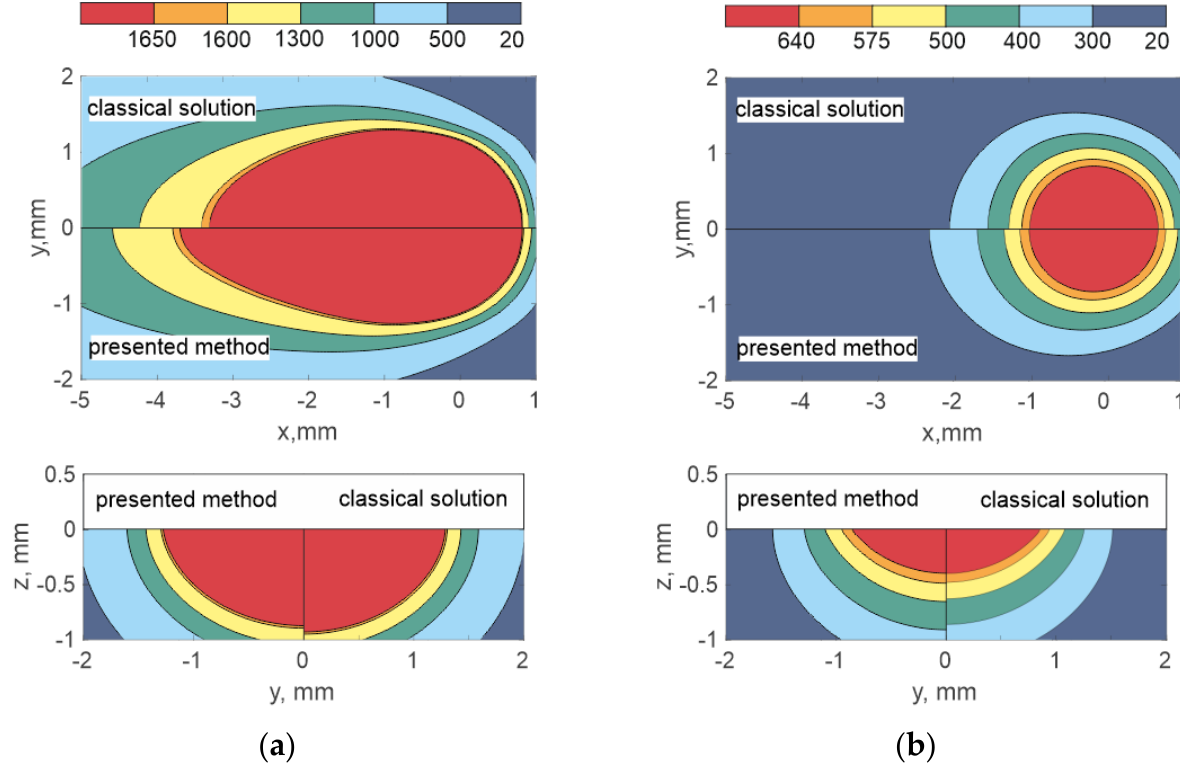
Figure 4. Estimated temperatures during laser deposition: ( a ) Ti6Al4V; ( b ) Al 5182.